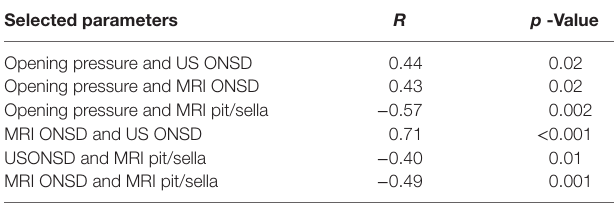
TaBle 2 | Correlations between selected parameters.